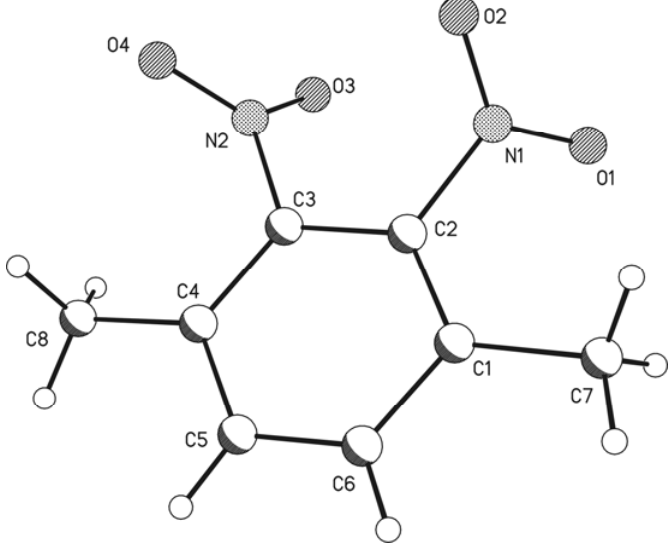
Figure 1. Molecular structure of DPX and the atom numbering